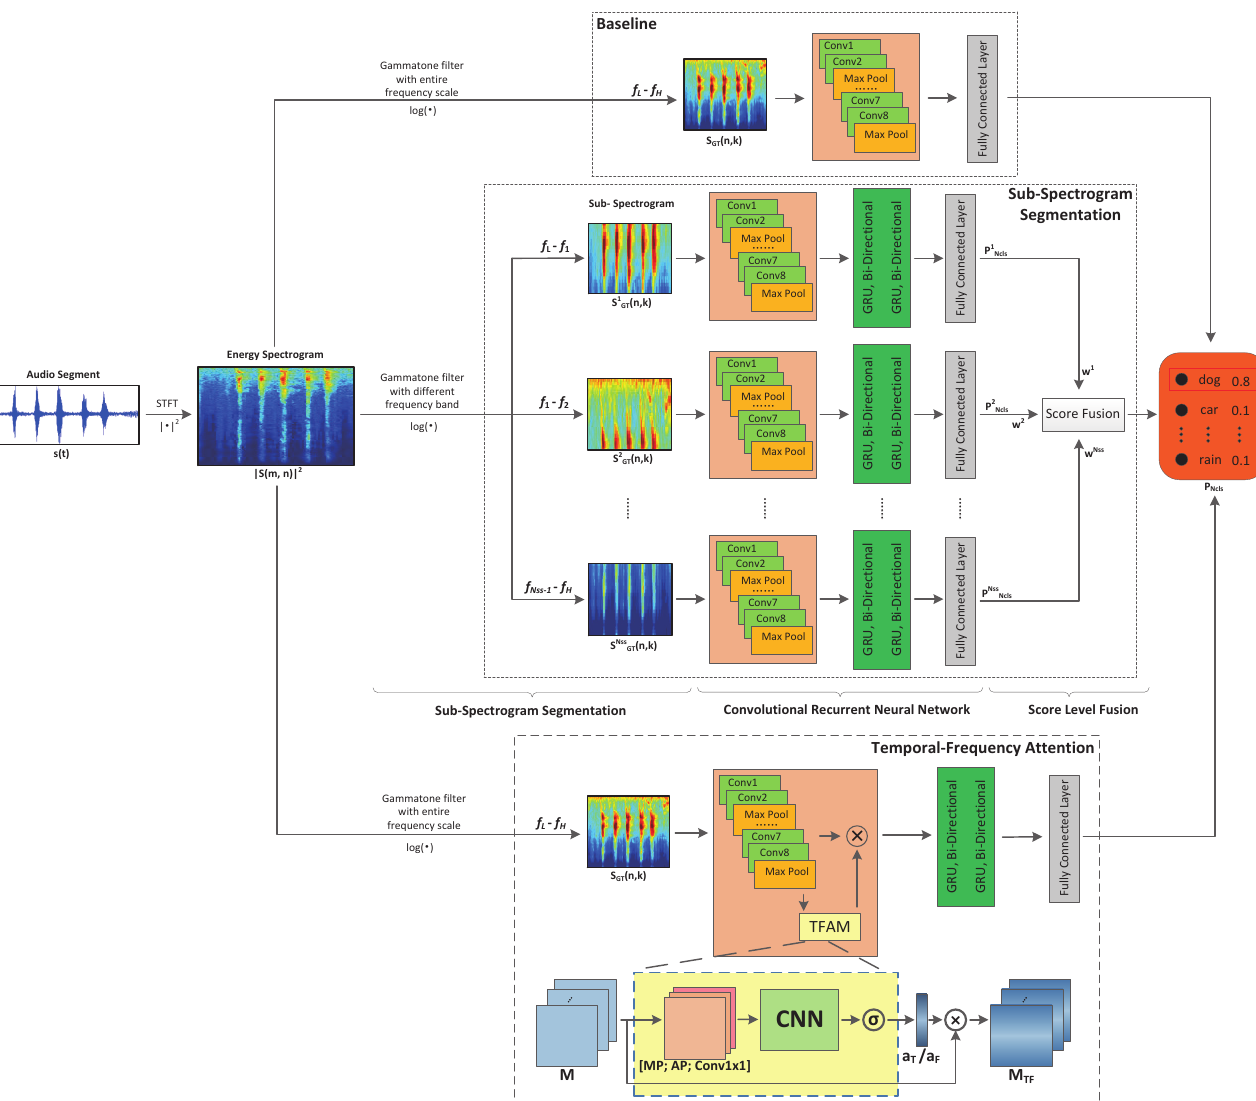
Figure 2. Compare the baseline system, the proposed sub-spectrogram segmentation system and the proposed temporal- frequency attention mechanism system. In this figure, the first branch denotes the baseline system, which extracts log Gammatone spectrogram features on the entire frequency band, the second branch denotes the proposed sub-spectrogram segmentation method, which extracts log Gammatone spectrogram on several sub-frequency bands as illustrated, and the last branch denotes the proposed temporal-frequency attention mechanism (TFAM) and temporal-frequency attention